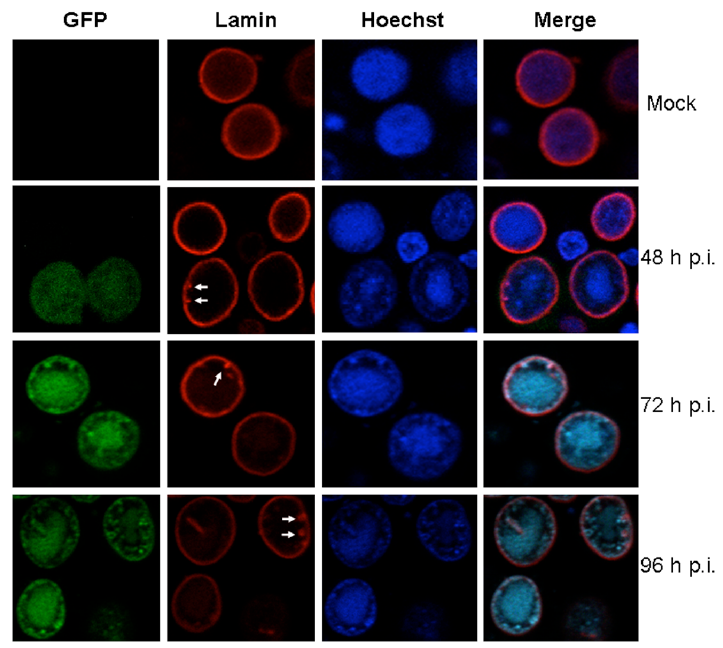
Figure 4. The conformational changes of nucleus lamin during AcMNPV infection. Sf9 cells were infected or mock-infected with vAcBac (expressing GFP) at an MOI of 5 and then fixed in 4% paraformaldehyde. The fixed cells were stained using the anti-Dm0 monoclonal antibody, ADL67, and visualized using a tetramethylrhodamine isothiocyanate-dextran (TRITC) labeled anti-mouse IgG (red). The nucleus was stained with Hoechst 33258 (blue). The white arrows indicate that the lamina showed a ruffled staining pattern with the formation of invaginations in Sf9 cells infected with Autographa californica multiple nucleopolyhedrovirus